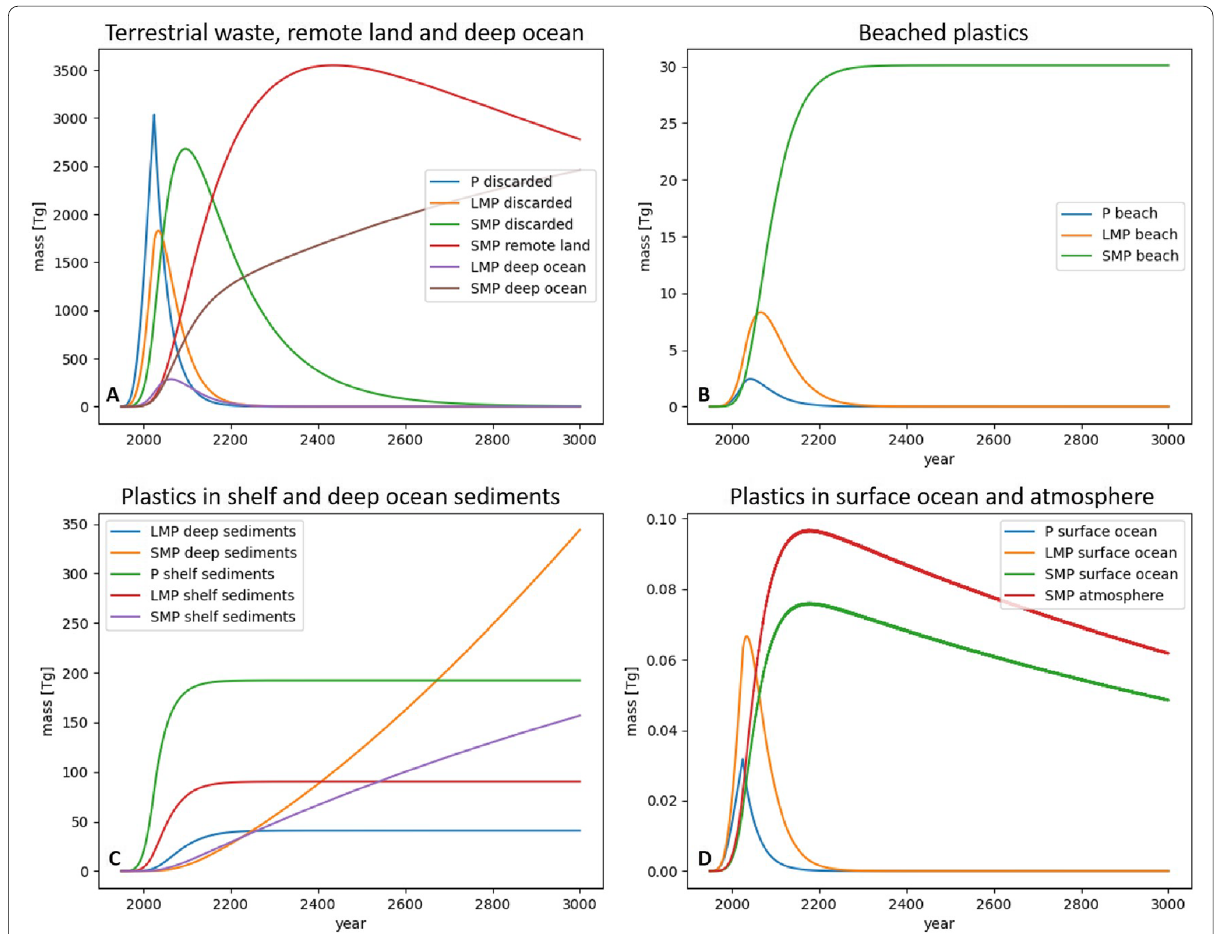
Fig. 3 Plastics dispersal through Earth surface reservoirs from 1950 to the year 3000, following a halt on production and discard in 2025. This unrealistic model scenario illustrates over what timescales discarded microplastic (P, > 5 mm), large microplastic (LMP) and small microplastic (SMP, < 0.3 mm) potentially disperse via rivers and air into oceans, remote terrestrial surfaces, beach and marine sediments. A P and LMP disappear in all transitory reservoirs within 100 and 200 years due to fragmentation at an annual rate of 3%. The prolonged dispersal of SMP in all reservoirs is driven by cyclical marine emissions to air, deposition to terrestrial surfaces, runoff to surface oceans, and re-emission to air. Only a small fraction of SMP sinks to shelf sediments and to the deep ocean, followed by slow sedimentation to deep ocean sediments. SMP mass, and concentrations, in the surface ocean and atmosphere, where human SMP exposure is relevant, only return to 2025 levels towards the year 5000 (Fig.